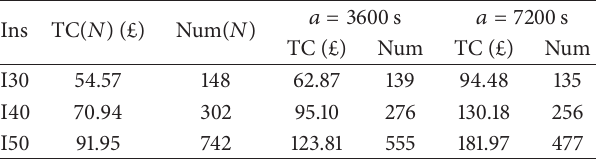
Table 5: Effect of the congestion.